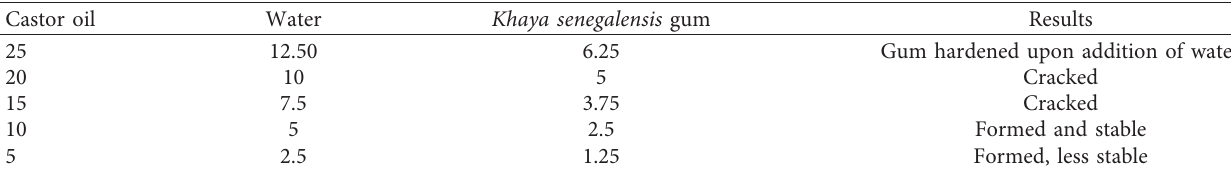
Table 5: Stability ratios of castor oil emulsions using Khaya senegalensis gum as an emulsifier.